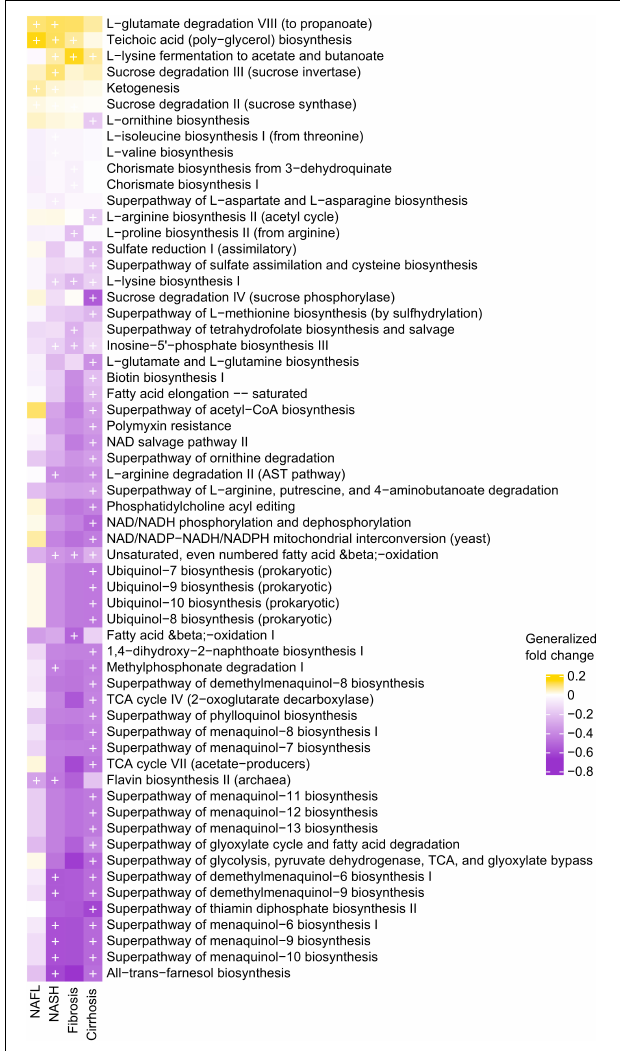
FIGURE 4 | Microbial metabolic pathways altered in NAFLD. The significance of gut microbial species derived from blocked two-sided Wilcoxon tests (+ indicates statistical significance FDR < 0.05). In the generalized fold-change color scale, yellow represents microbial pathways that were increased in the NAFLD group compared with the healthy control group, while purple represents pathways that were decreased in the NAFLD group compared with the healthy control group. NAFL, non-alcoholic fatty liver; NASH, non-alcoholic